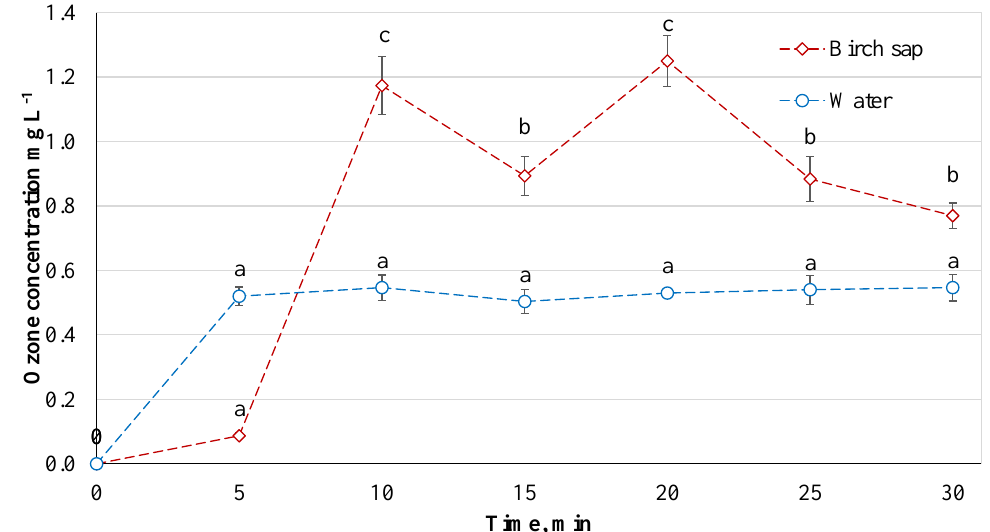
Figure 2. Changes of ozone concentration in sap and water. A Tukey HSD test was used to compare the means of ozone concentrations in sap and water ( p < 0.05, n = 6). Means in points marked by the same lowercase letter are not significantly different ( p < 0.05).